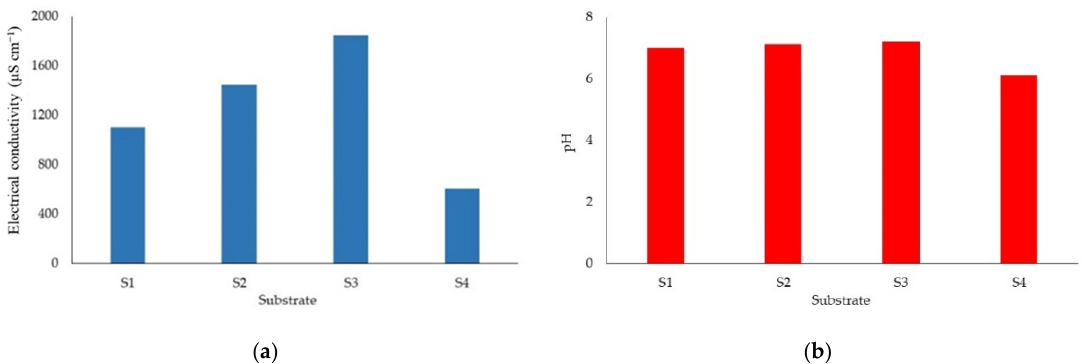
Figure 3. Chemical properties of substrates. Graph ( a ) refers to electrical conductivity values, while graph ( b ) refers to pH values of substrates.